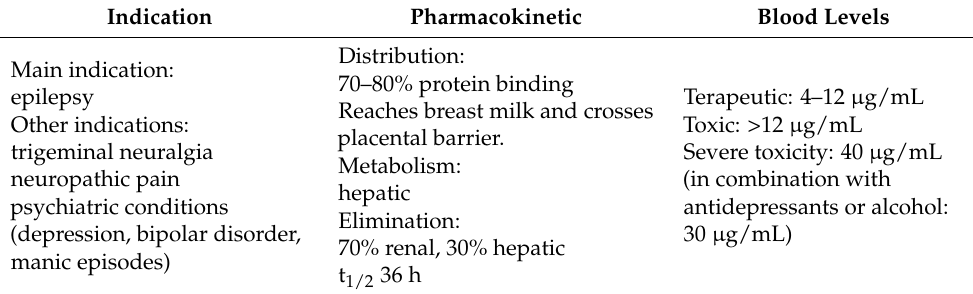
Table 1. Carbamazepine indications, pharmacokinetics, and reference blood